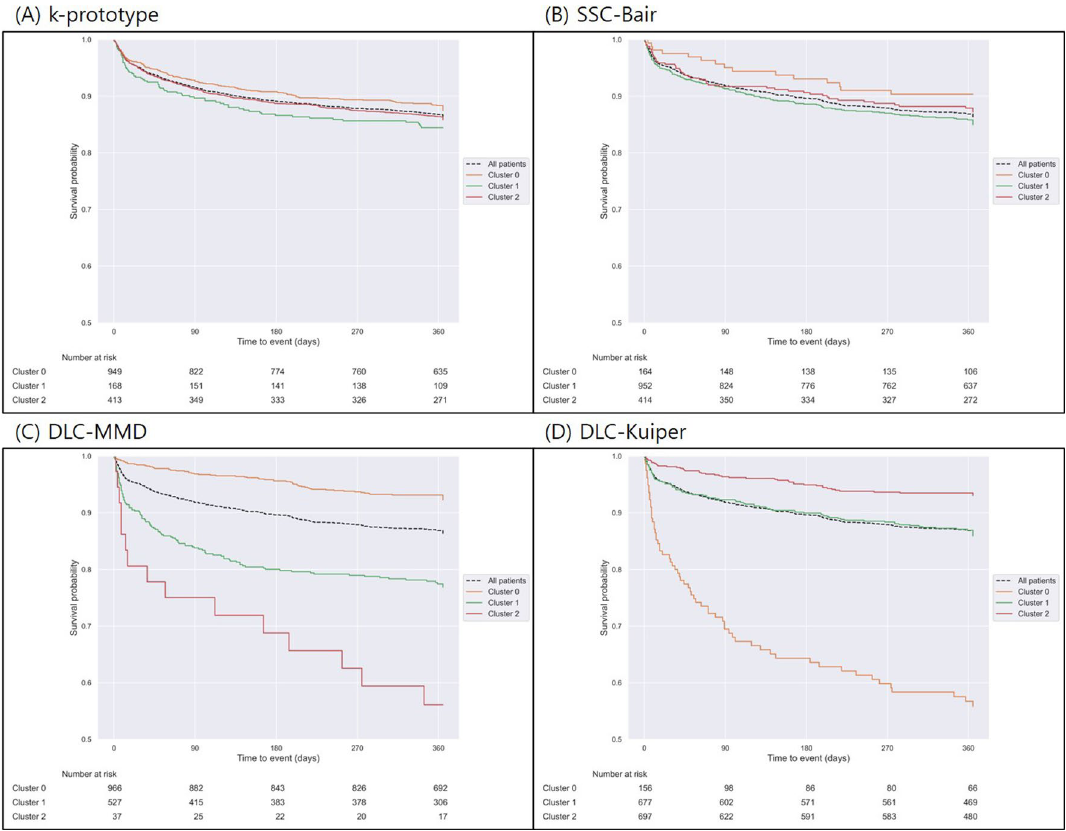
Figure 2. Kaplan–Meier curves of the primary outcome within 1 year from different clustering methods for K = 3 (3 clusters). ( A ) K-prototype, ( B ) SSC-Bair, ( C ) DLC-MMD, and ( D ) DLC-Kuiper UB, all test set